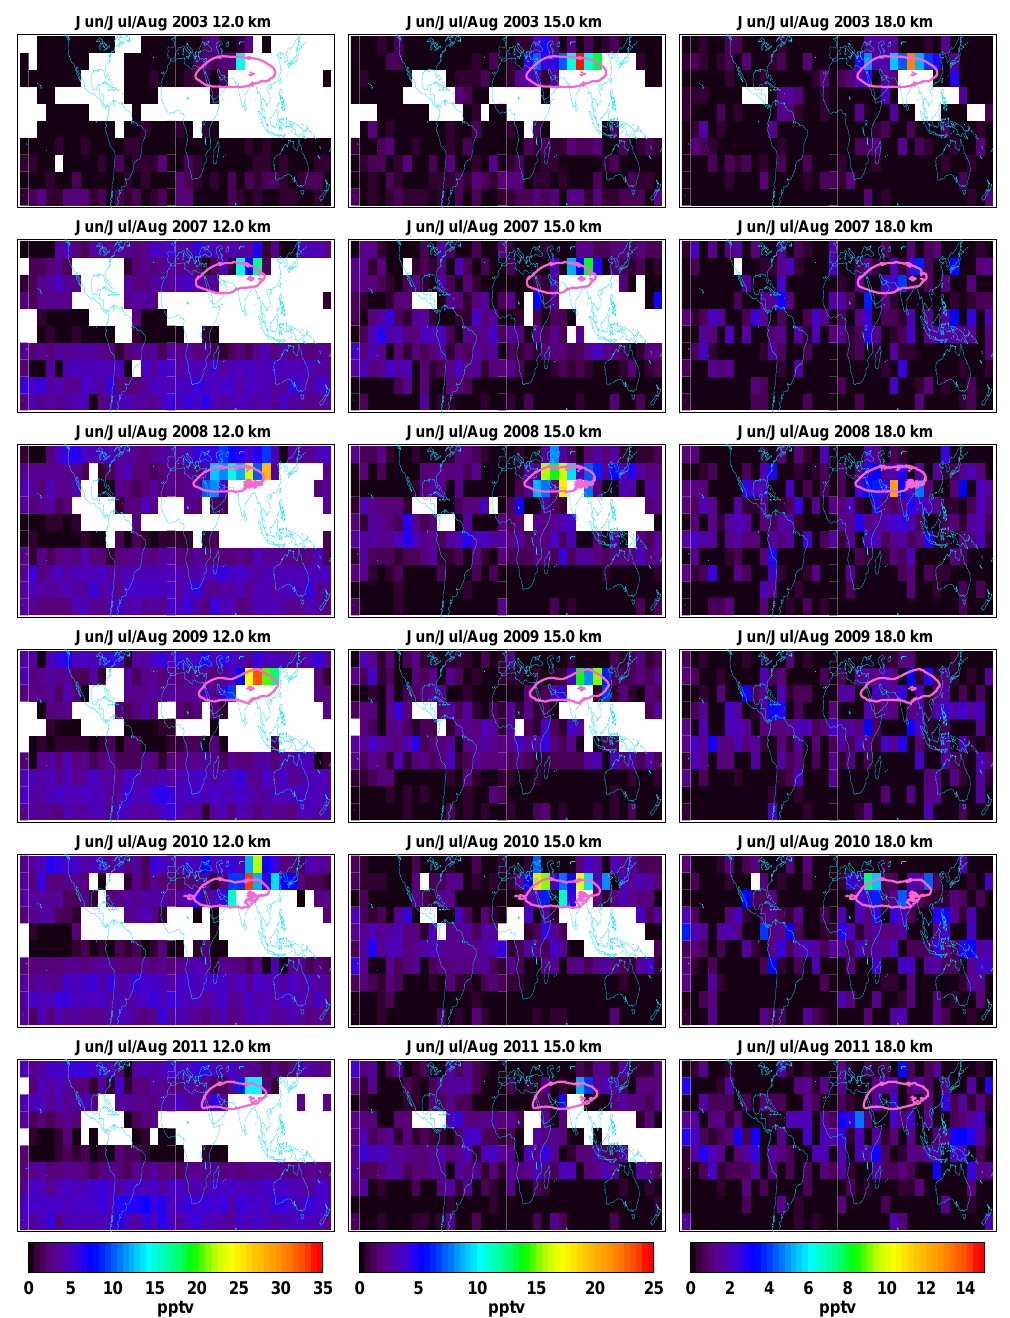
Figure 5. Distributions of NH 3 volume mixing ratios at 12, 15, and 18km altitude between 50 ◦ N and 50 ◦ S retrieved from MIPAS seasonal mean spectra during the Asian monsoon period for several years. Pixels where not enough spectra for averaging were available are left white. Pink contour lines denote the mean position of the Asian monsoon anticyclone for June, July, and August as described in the caption of Fig.